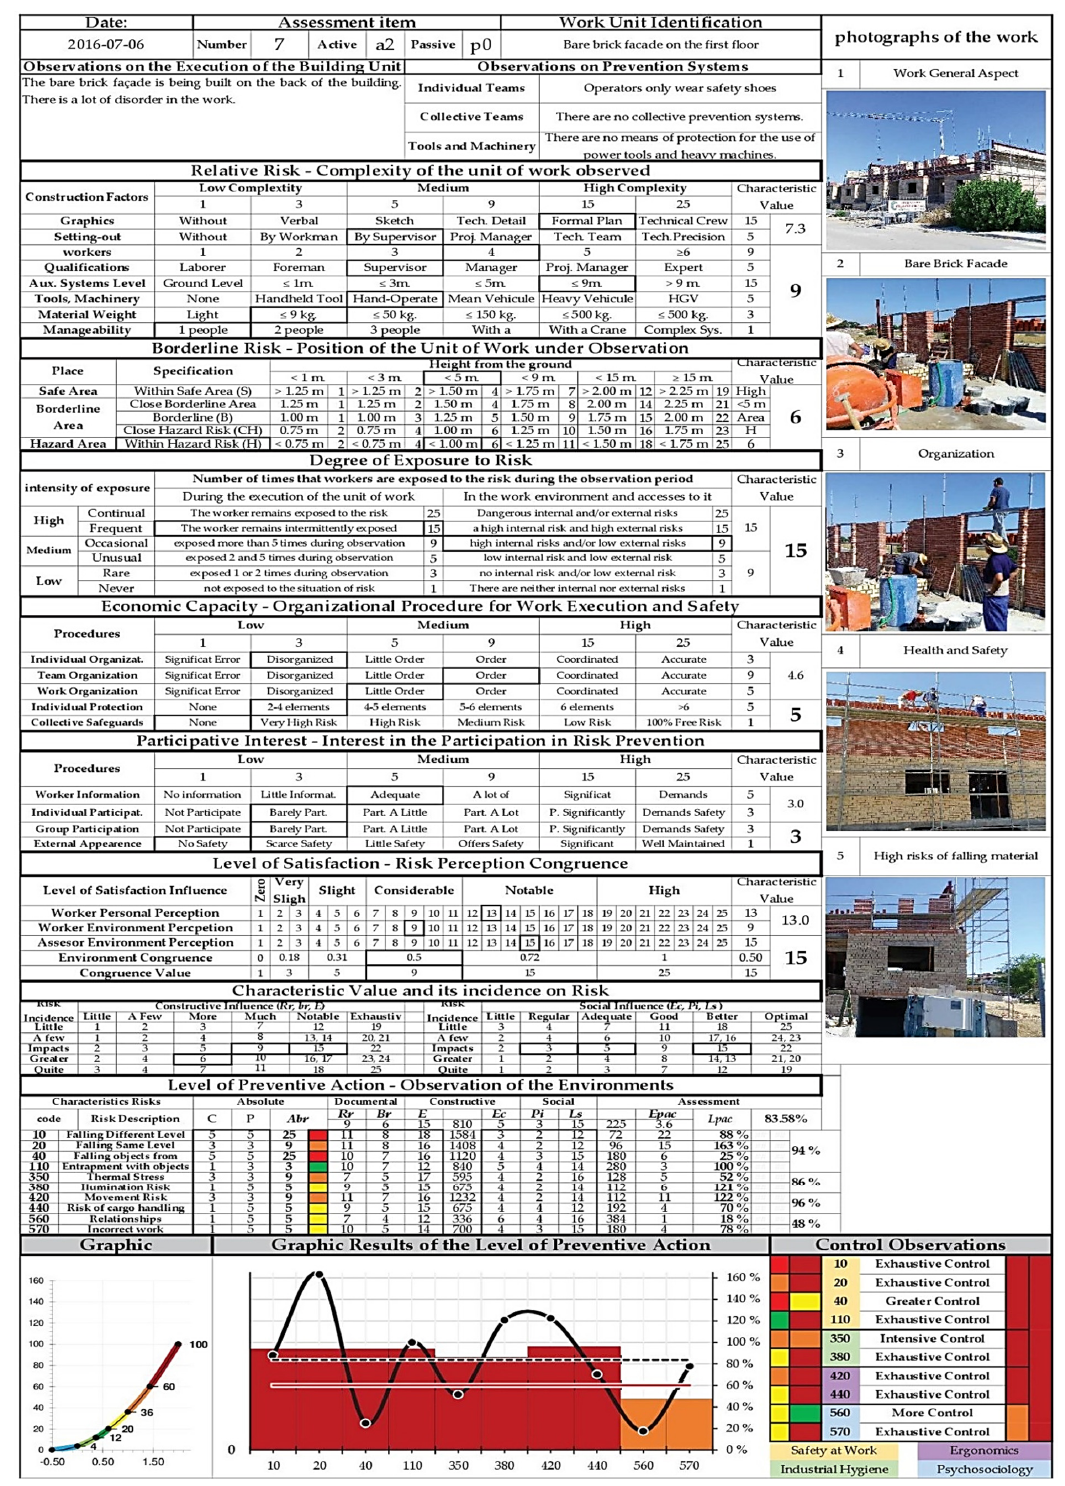
Figure A1. Help sheet for data collection and calculation of the characteristic value, its incidence on the risk, level of preventive action, and preventive action controls.